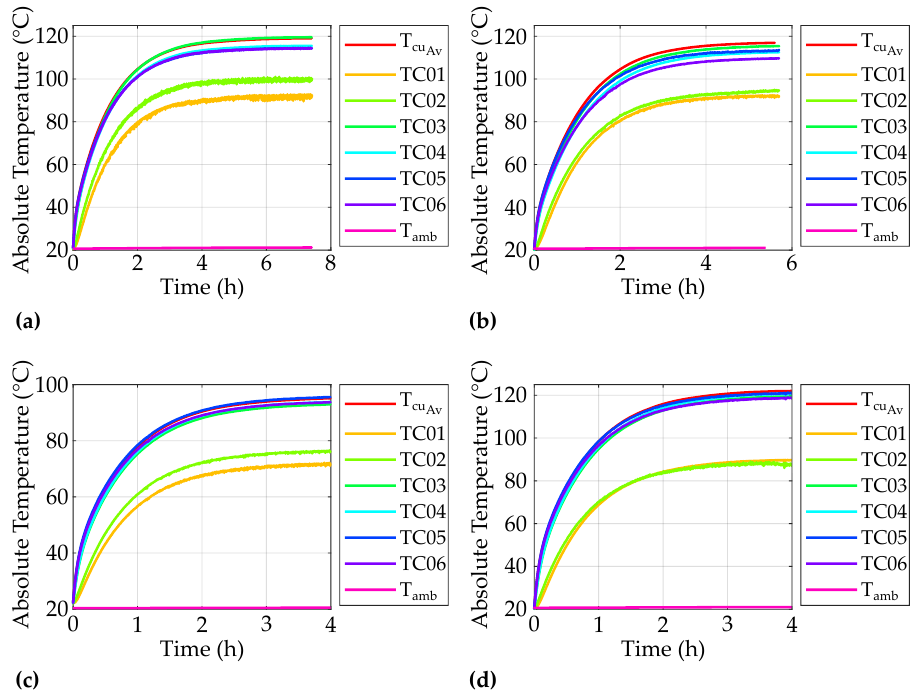
Figure 10. Results of the thermal tests of the LIM. ( a ) Horizontal at 135 W. ( b ) Vertical at 135 W. ( c ) Vertical with aluminium plate at 135 W. ( d ) Vertical with aluminium plate at 195 W.